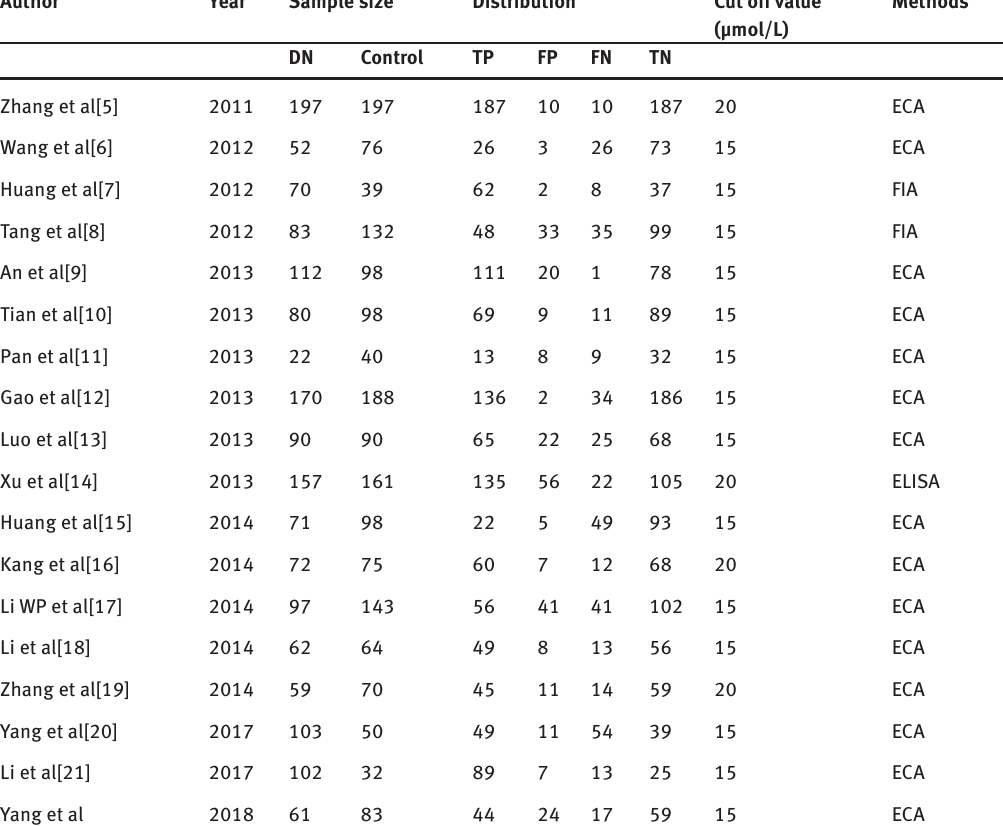
Table 1: The general characters of the included 18 publications.